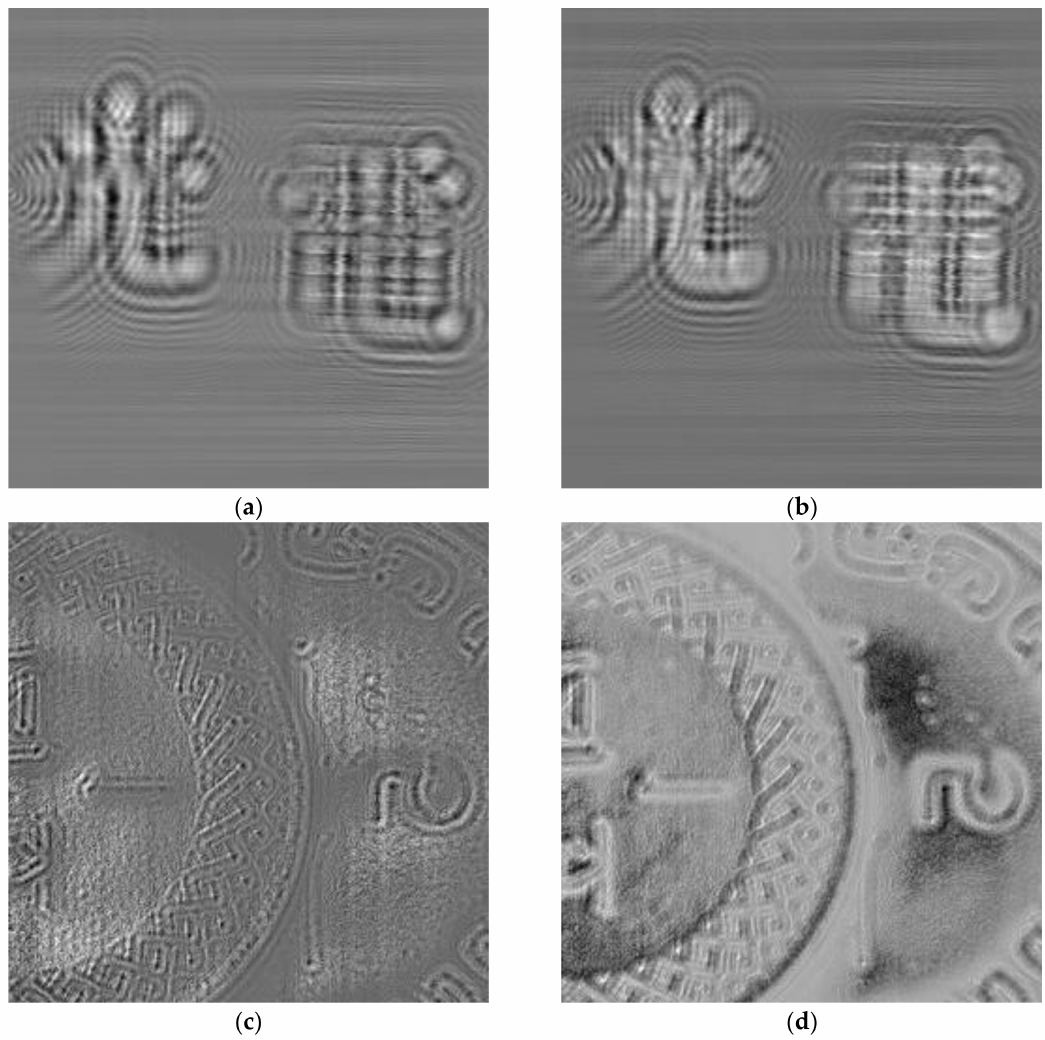
Figure 4. ( a ) Sine hologram of hologram “A”; ( b ) Cosine hologram of hologram “A”; ( c ) Sine hologram of hologram “B”; ( d ) Cosine hologram of hologram